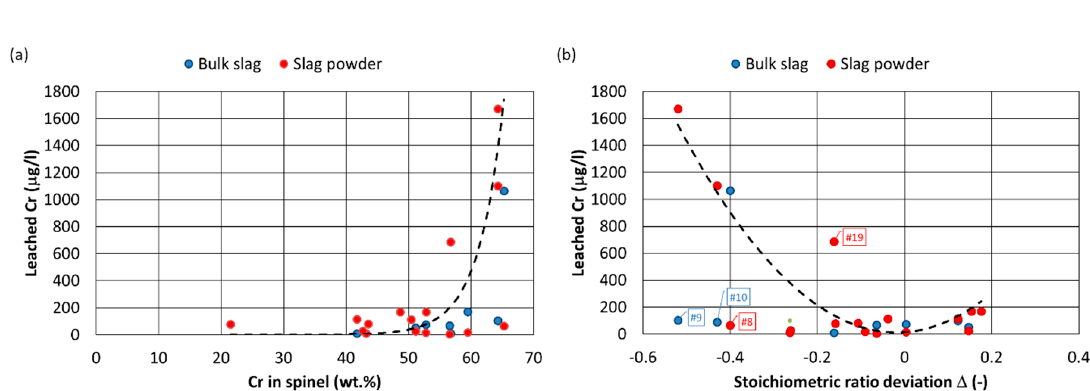
Figure 6. Effect of Cr ( a ) and stoichiometric ratio deviation ( Δ ) ( b ) on Cr leaching.